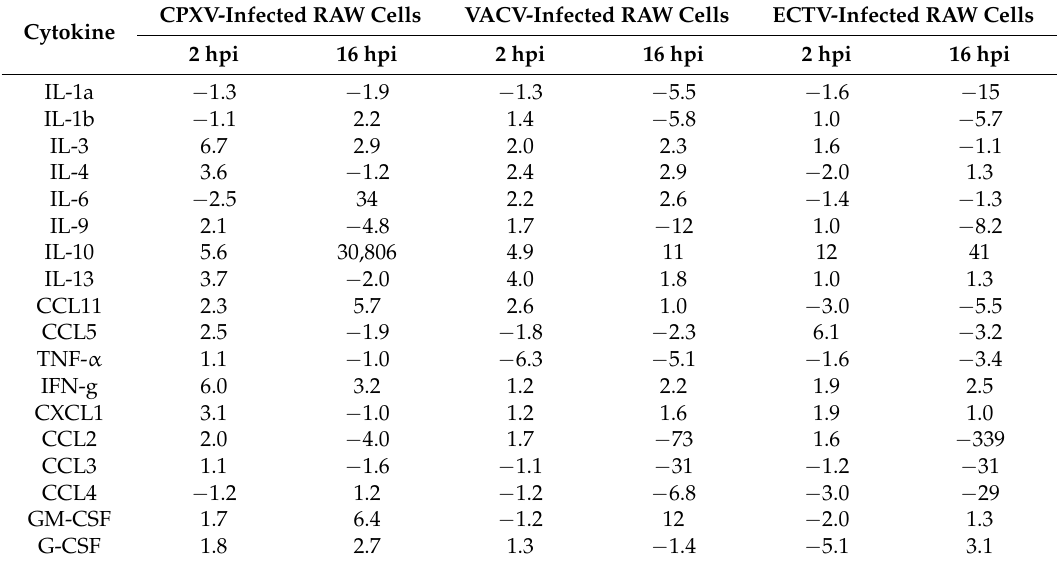
Table 2. Changes in Cytokine mRNA measured using PCR array in RAW cells infected with cowpox virus (CPXV), vaccinia virus (VACV), and ectromelia virus (ECTV). CPXV-Infected RAW Cells VACV-Infected RAW Cells ECTV-Infected RAW Cells Cytokine 2